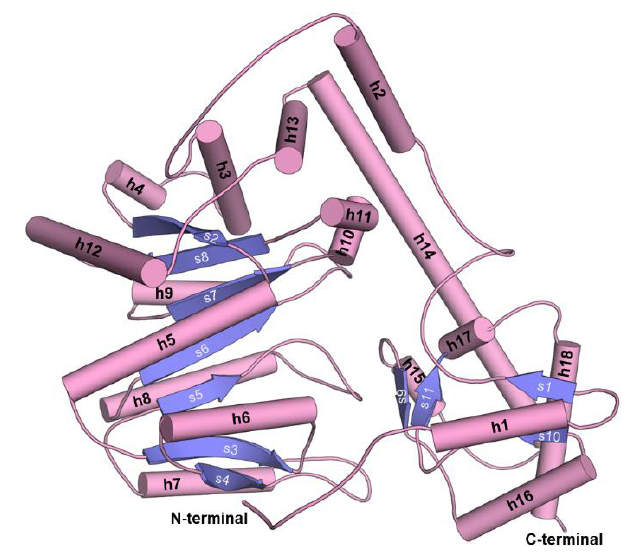
Figure 3. Secondary structure elements in Psy ArAT monomer.